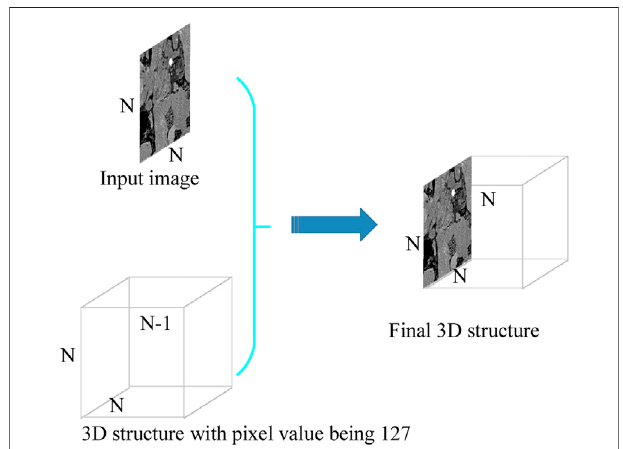
FIGURE 1 | Schematic diagram of deep gray